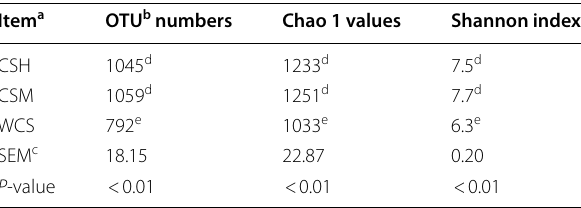
Table 1 The α diversity of bacterial community attached to cotton by‑products after an incubation of 24 h